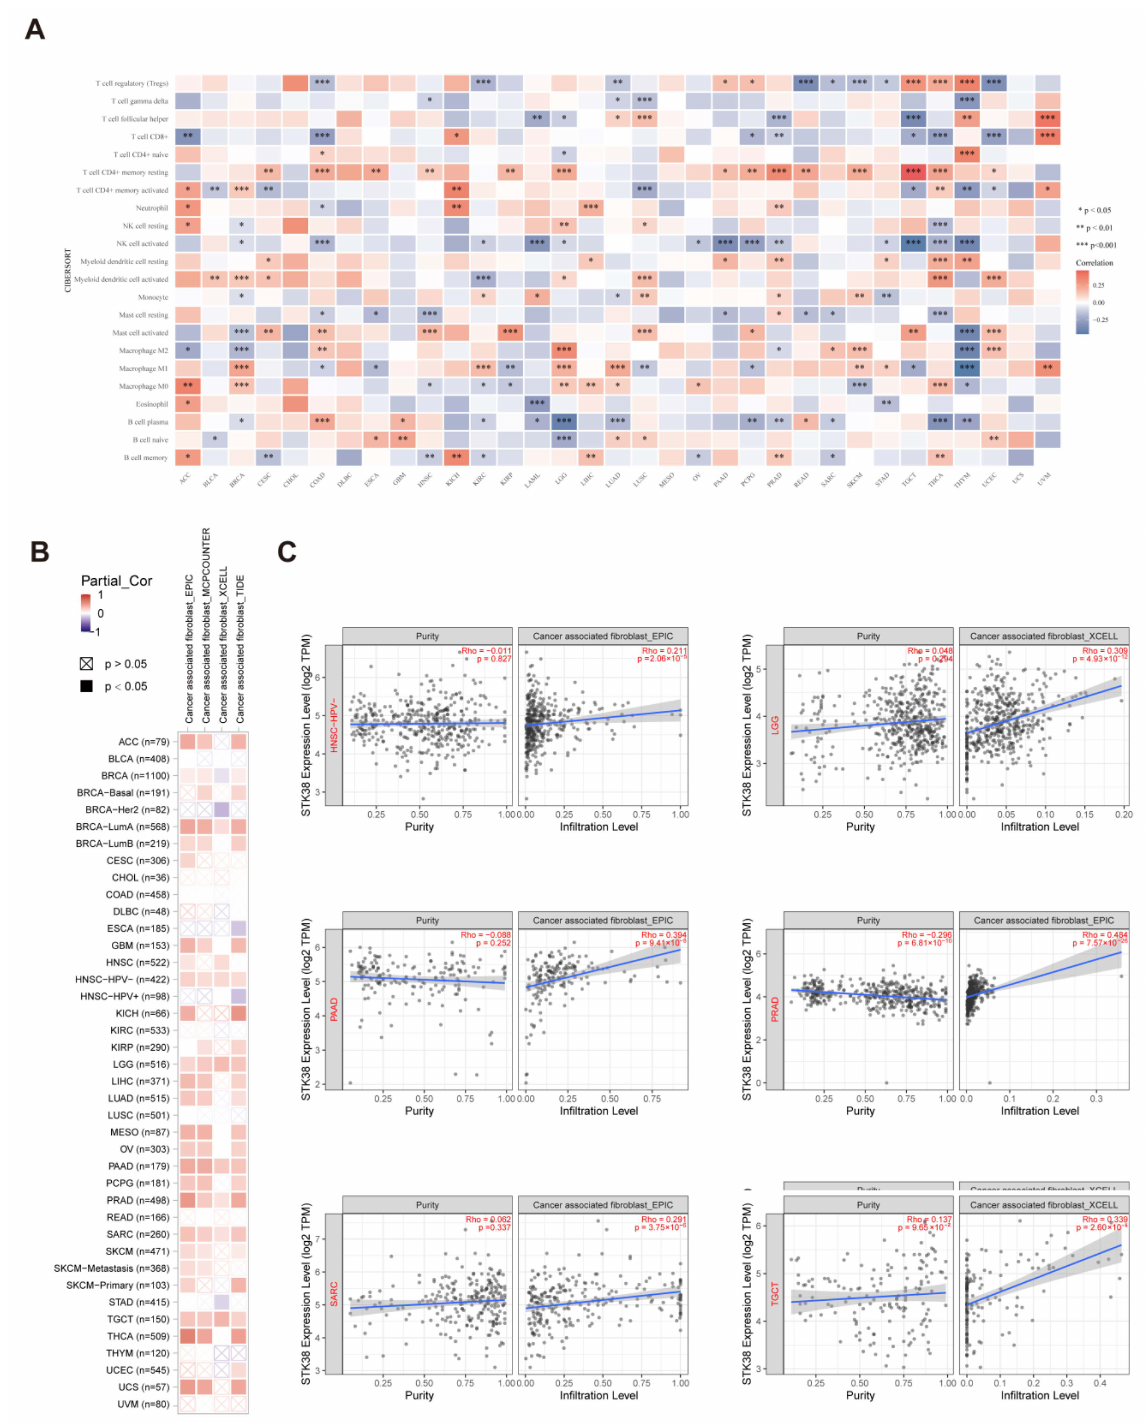
Figure 5. Relationship between STK38 expression and immune infiltration ( A ) The expression of STK38 is significantly correlated with a variety of immune cells infiltration levels based on CIBER- SORT. * p < 0.05, ** p < 0.01, and *** p < 0.001. ( B ) The potential correlation analysis of STK38 expression and immune infiltration of cancer-associated fibroblasts. The red color represents a posi- tive relationship (0–1), while the blue color indicates a negative relationship ( − 1–0). The relationship with p -value < 0.05 is statistically significant. Statistically non-significant relationship are labeled with a cross. ( C ) The scatter plots of related cancers including HNSC-HPV-, LGG, TGCT, PRAD, SARC and